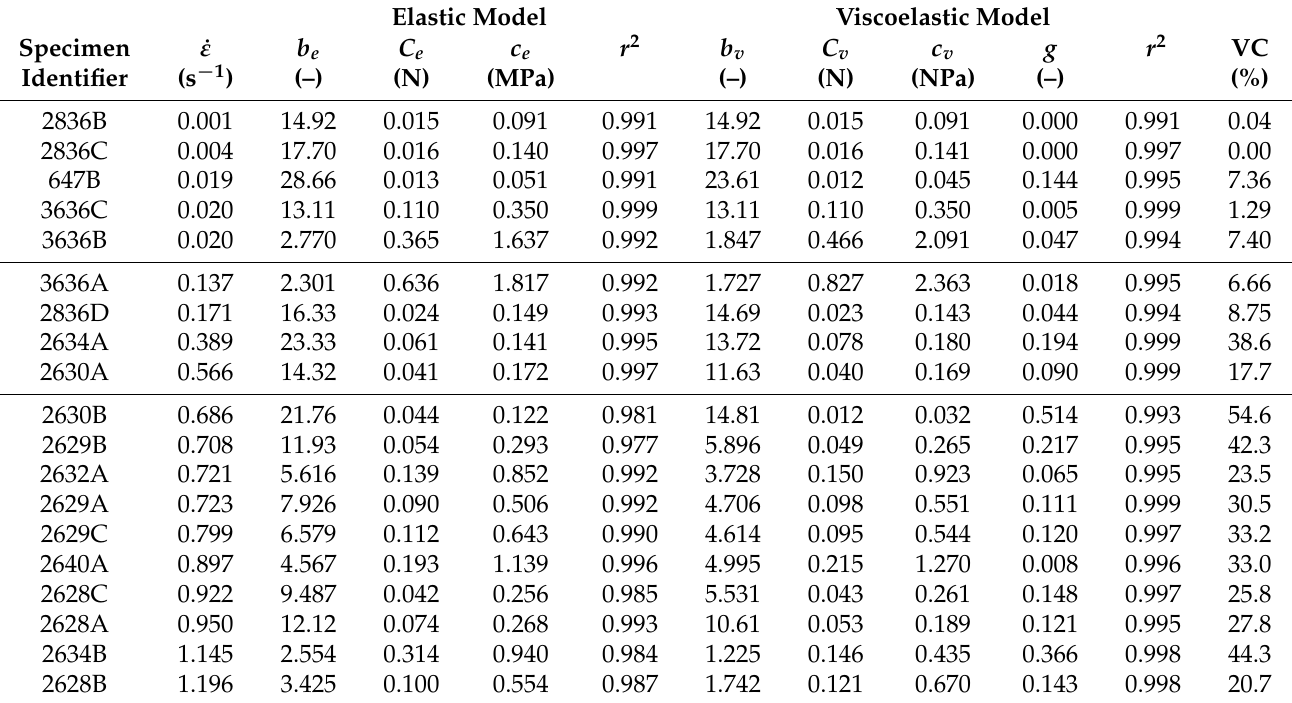
Table 2. Fitted constitutive parameters for elastic and viscoelastic models. Elastic Model